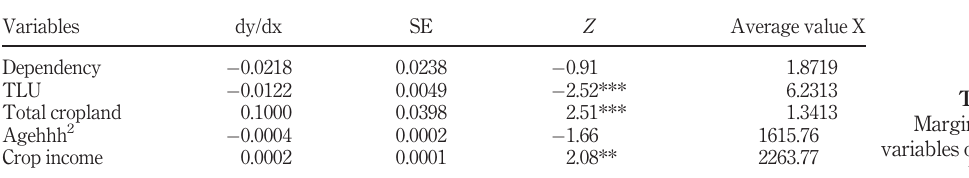
Table VIII. Marginal effect